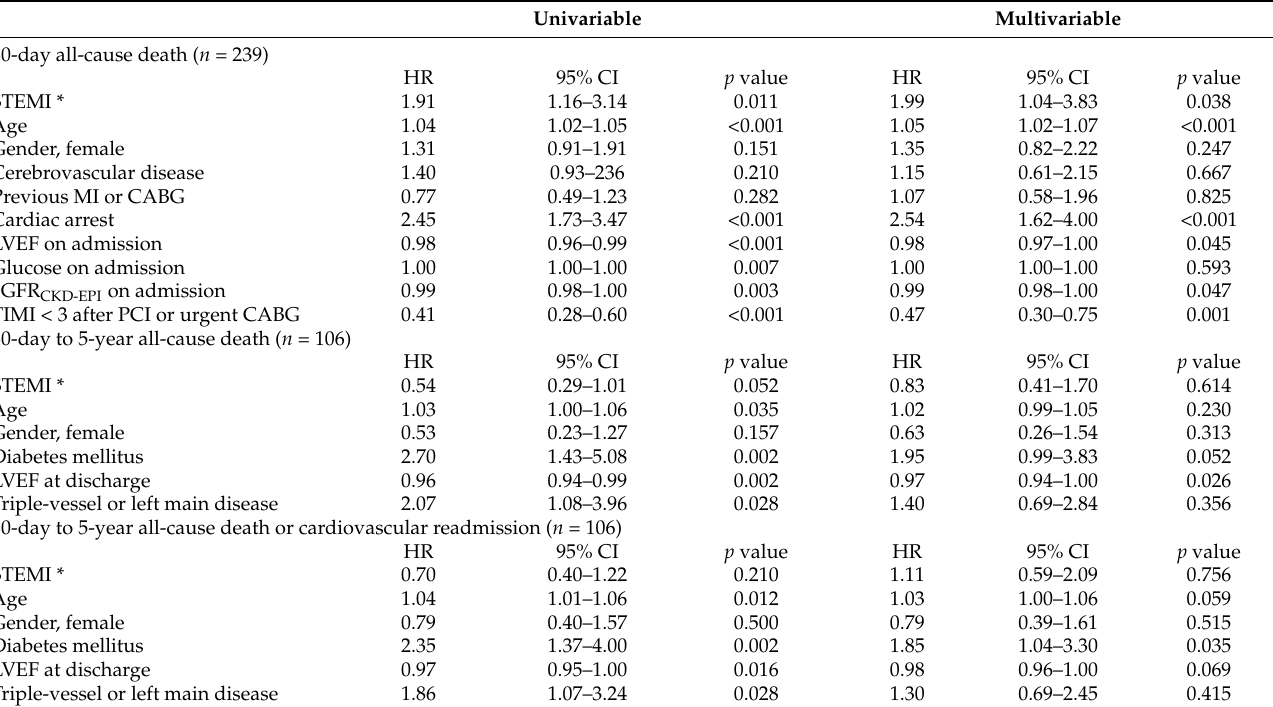
HR 95% CI p value HR 95%